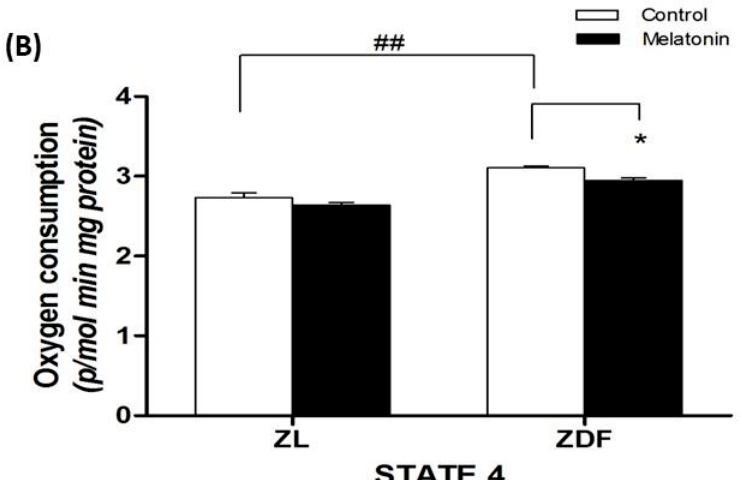
Figure 2. Effect of melatonin treatment on the respiratory states in isolated mitochondria from renal tissue. ( A ) The upper panel shows the state 3 (oxygen flux while producing ATP in response to ADP pulses in the presence of substrates). ( B ) The lower panel documents the state 4 or leak respiration (oxygen flux in the absence of ATP synthesis). Glutamate/malate was used as respiratory substrates. Values are the means ± S.E.M. ZL, Zücker lean rats ( n = 8); ZL-M (ZL – melatonin treated) ( n = 8), ZDF, Zücker diabetic fatty rats ( n = 8), and Zücker diabetic fatty-M (ZDF- melatonin treated) ( n = 8) rats, after 16 weeks of treatment. (*** p < 0.001, * p < 0.05 M-ZDF compared with C-ZDF, and M-ZL